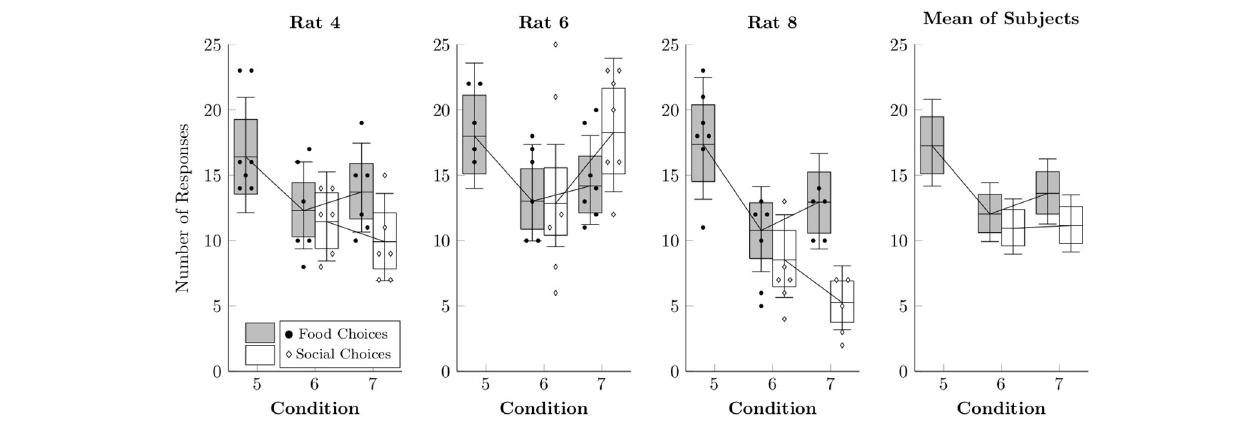
FIGURE 6 | Estimated rates at which food choices (black circles) and social choices (white diamonds) were made for each of the rats in Conditions 5–7 based on a multi-level negative binomial regression, as well as observed event counts. Points represent event counts for each session, whereas boxes represent the 80% credible interval and whiskers represent the 95% credible interval of the estimated rate.